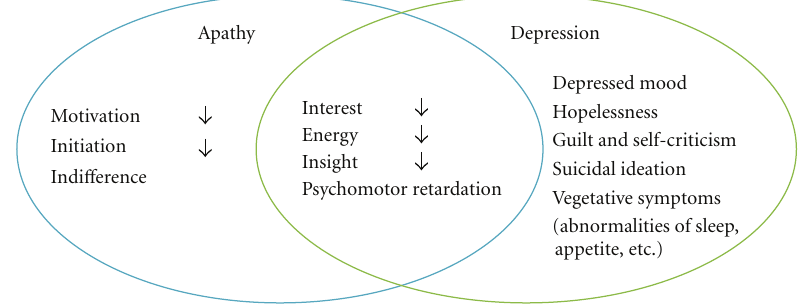
Figure 1: Apathy versus